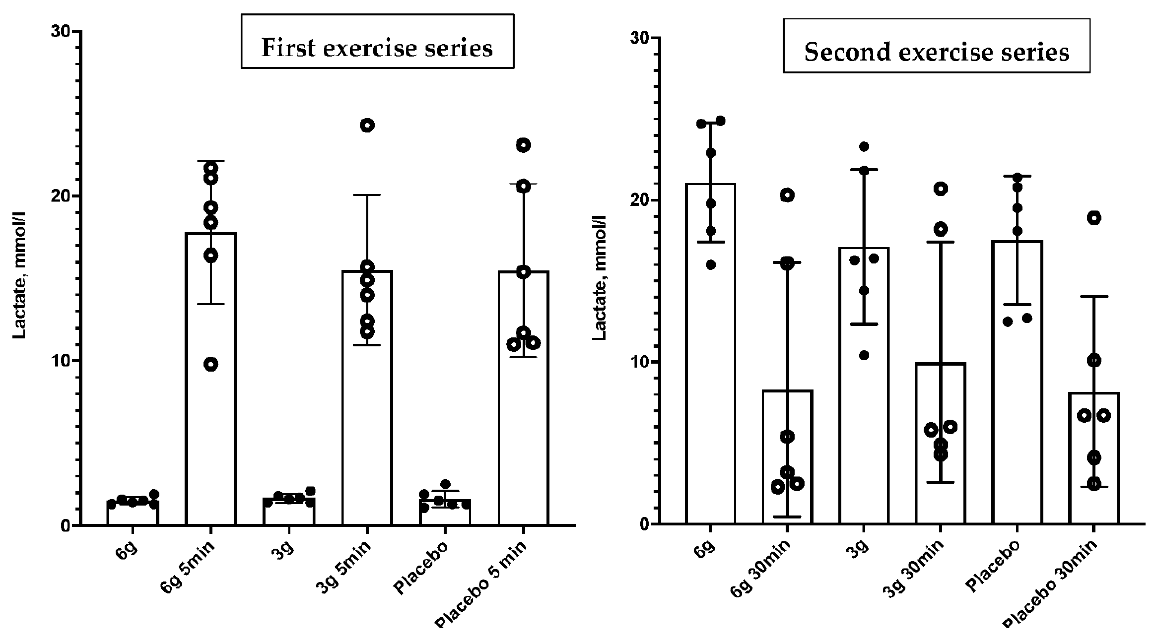
Figure 2. Blood-lactate changes before and after the field-based soccer-specific test.